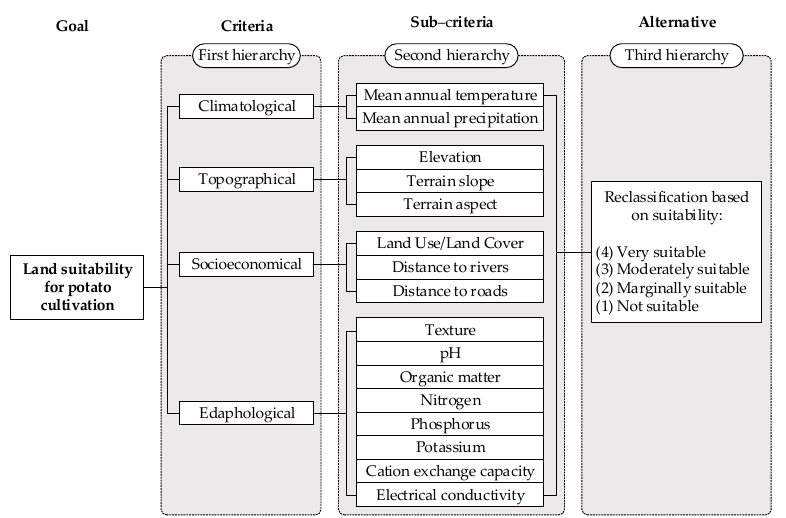
Figure 3. Variable hierarchization for land suitability modelling for potato cultivation in the Jucusbamba and Tincas microwatersheds (Amazonas, NW Peru).